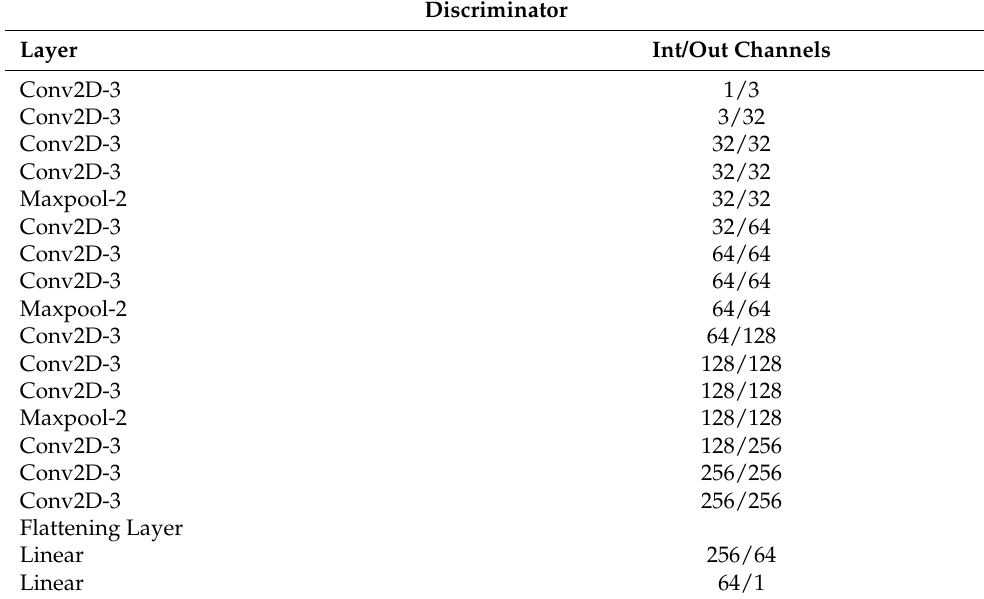
Table 2. Architecture of the discriminator